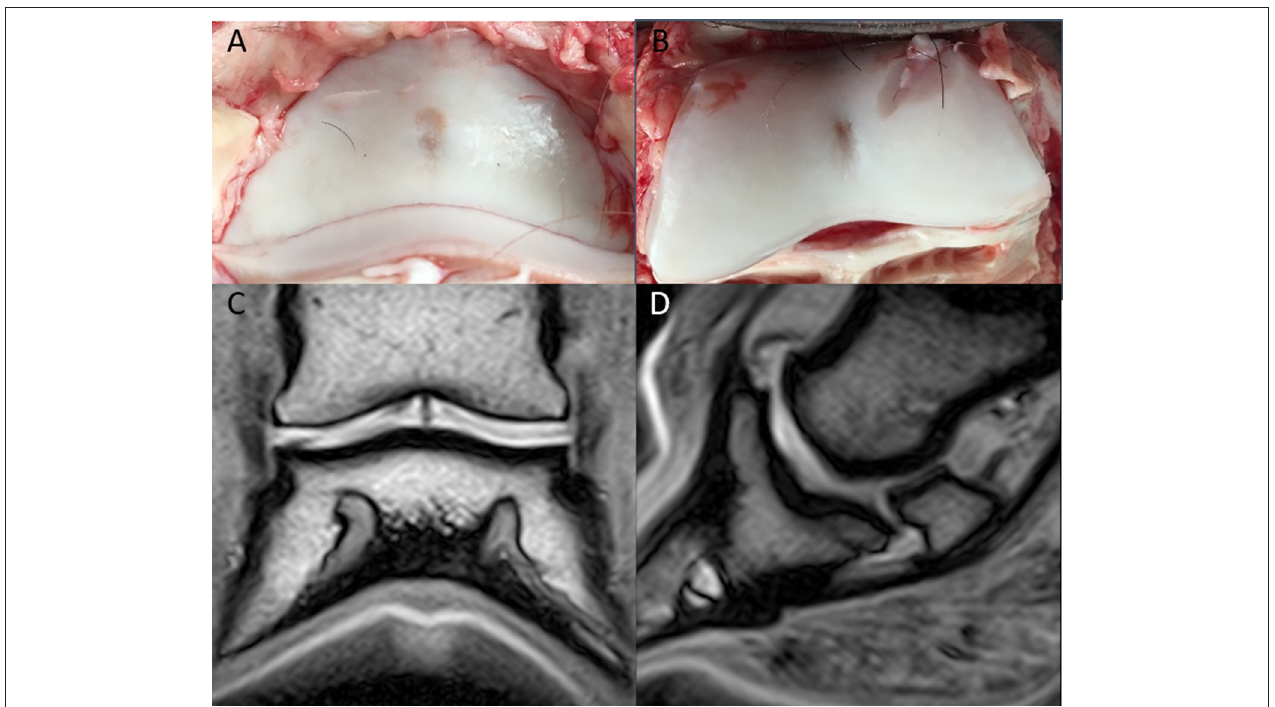
FIGURE 1 | Clinical case from the pilot study, horse one. Medial is to the left. In the axial aspect of the distal phalanx (A) , and the middle phalanx (B) , there is a focal cartilage defect. Note the sharp-edged artifactual cut into the cartilage during preparation (B) ; Dorsal (C) , and sagittal (D) T1-weighted sequences in plain low-field MR imaging. An irregular joint space and a hypointense signal are visible in the axial aspect of the articular cartilage of the distal and middle